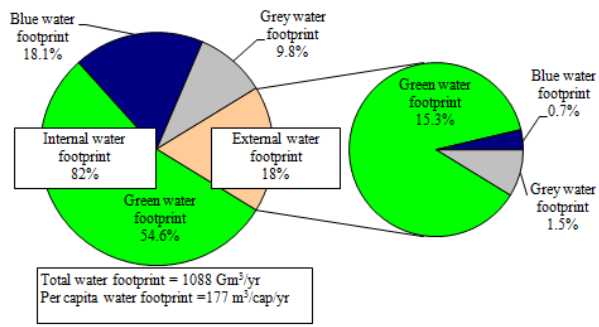
Fig. 4. Global water footprint related the consumption of wheat products. Period: